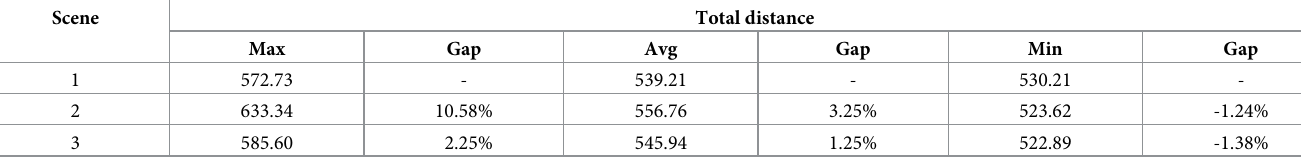
Table 4. Statistical results of each